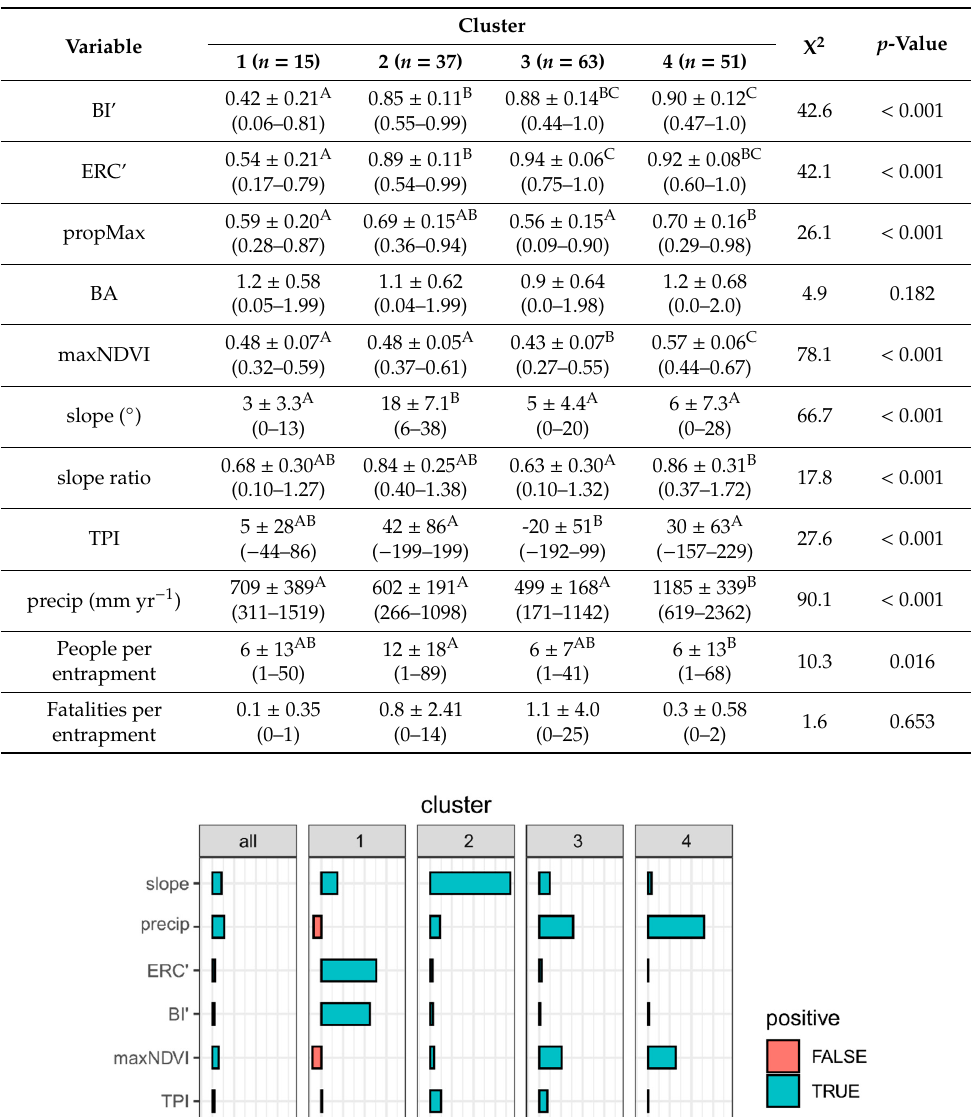
Table 4. Descriptive information for each entrapment cluster along with group comparisons based on the Kruskal–Wallis test [43] followed by multiple comparisons using Dunn’s test [44]. Data shown for each cluster are mean ± standard deviation and the ranges (in round brackets). See Table 2 for definitions of variables, n is sample size. Clusters with common superscript letters are not significantly di ff erent by Dunn’s test at the 5% level of significance.